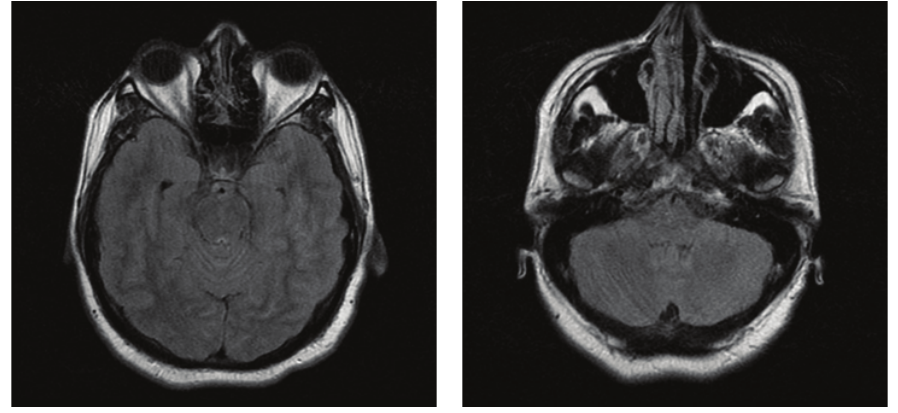
Figure 1: Brain MRI in FLAIR sequence, without abnormalities.